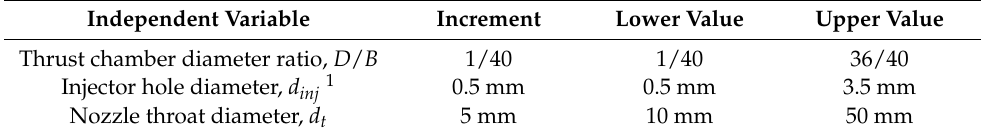
Table 5. Domain of